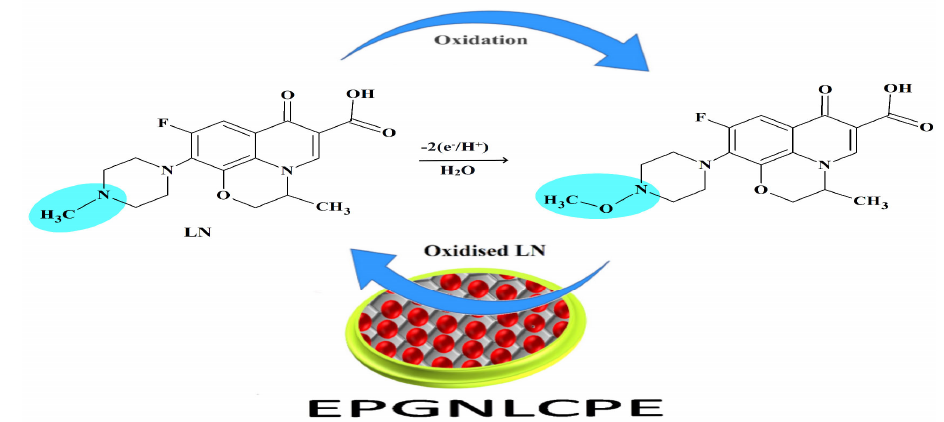
Figure 8. Probable electrochemical redox reaction of LN on EPGNLCPE